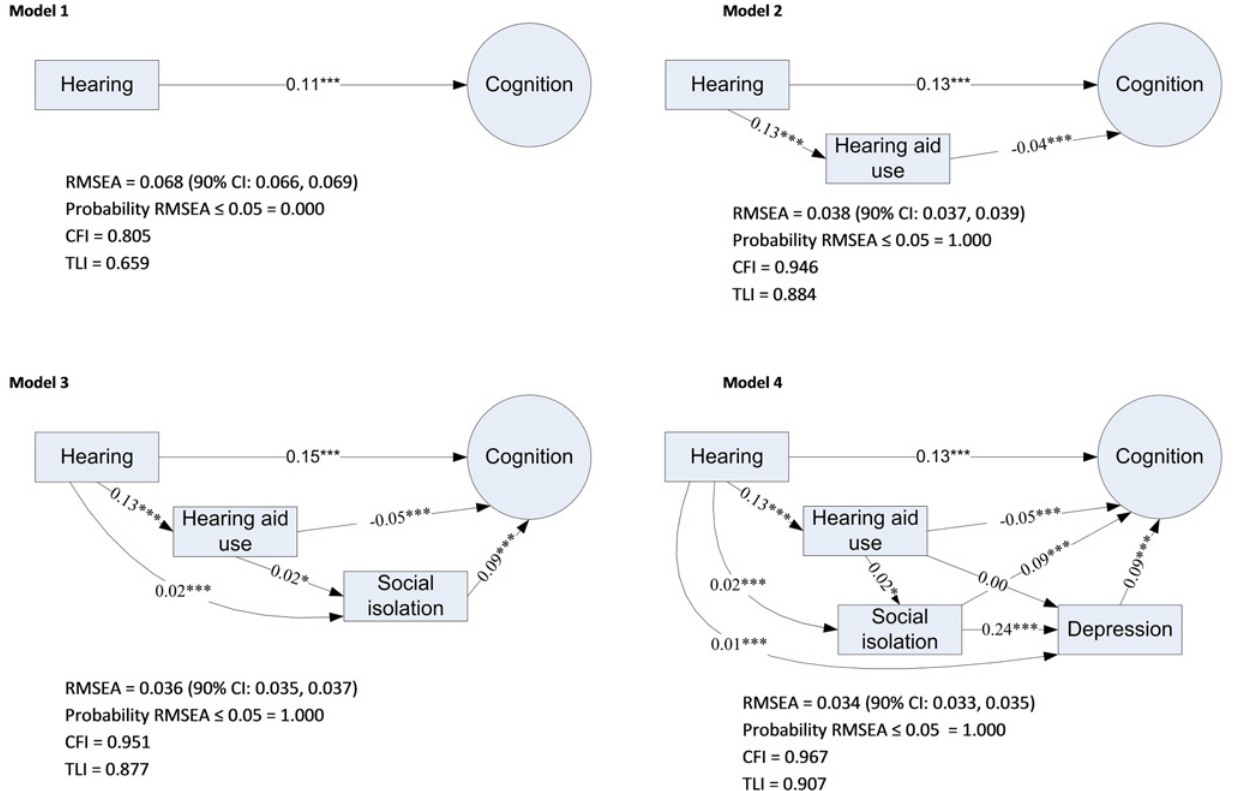
Fig 1. Structural equation models of standardised path coefficients between hearing, cognition, hearing aid use, social isolation and depression. Notes: *** p < 0.001, * p < 0.05. Root Mean Square Error of Approximation (RMSEA). A value less than 0.05 indicates good fit. Comparative Fit Index (CFI) and Tucker Lewis Index (TLI), with a number greater than 0.95 indicating good